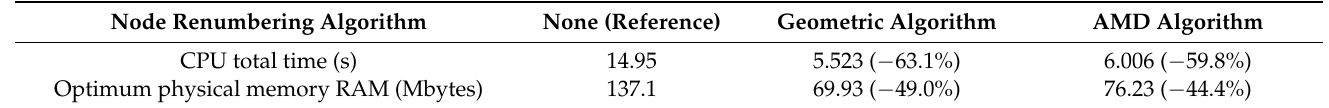
Table 3. Performance test on an out–of–plane loaded masonry wall (35 × 65 elements) for two–node renumbering algorithms and within a direct sparse